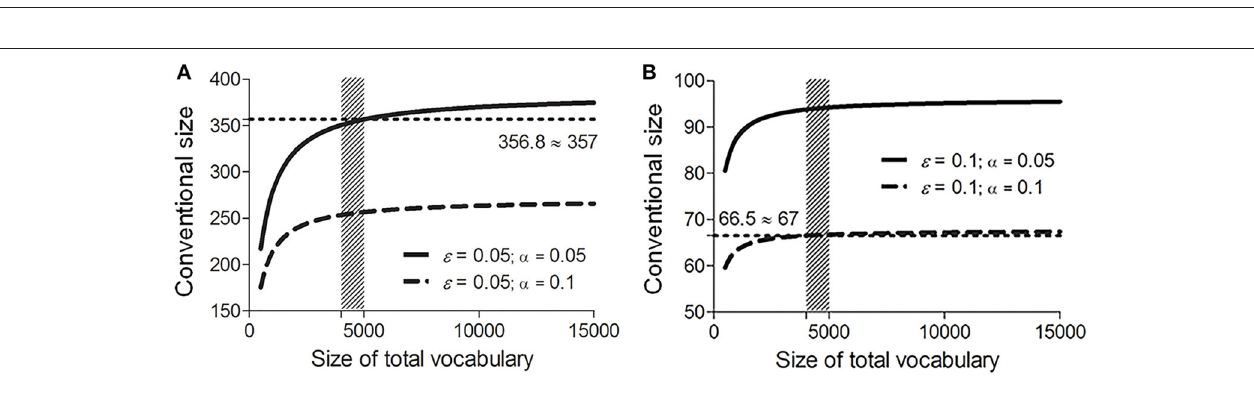
FIGURE 2 | Conventional sizes of the vocabulary list under fixed error rate ε [0.05 (A) and 0.1 (B) ] and significance level α [0.05 (solid lines) and 0.1 (dash lines)], and various total vocabulary sizes N (500–15000). Shade areas mark the range where N is between 4000 and 5000. Dotted lines mark the range of the conventional size n (round-up to the closest integers) calculated using Equation